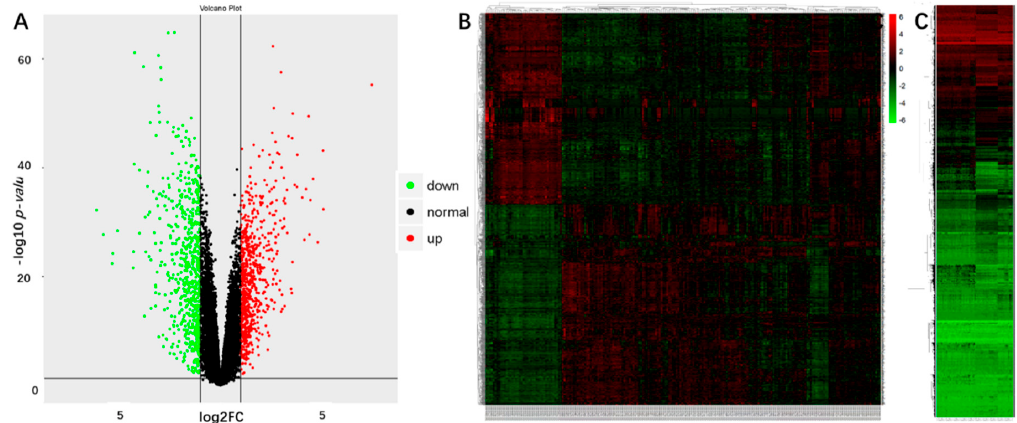
Figure 1. The results of differentially expressed genes (DEGs) in GSE30784, and differentially methylated probes (DMPs) in GSE38532. ( A ) Volcano Plot visualizing the DEGs. The vertical lines demark the fold-change values. The right vertical line corresponds to log2FC > 1 changes, while the left vertical line corresponds to log2FC < − 1 changes. The horizontal line marks a − log10 p -value of 0.05. ( B ) Heat-map hierarchical clustering revealed 1417 genes that were differentially expressed in oral squamous cell carcinoma (OSCC) groups when compared with control groups. Red and green colors indicate higher expression and lower expression, respectively. ( C ) Heat map of the DMPs. Hierarchical clustering showed separate groupings of DMPs for OSCC tissue and normal tissue.